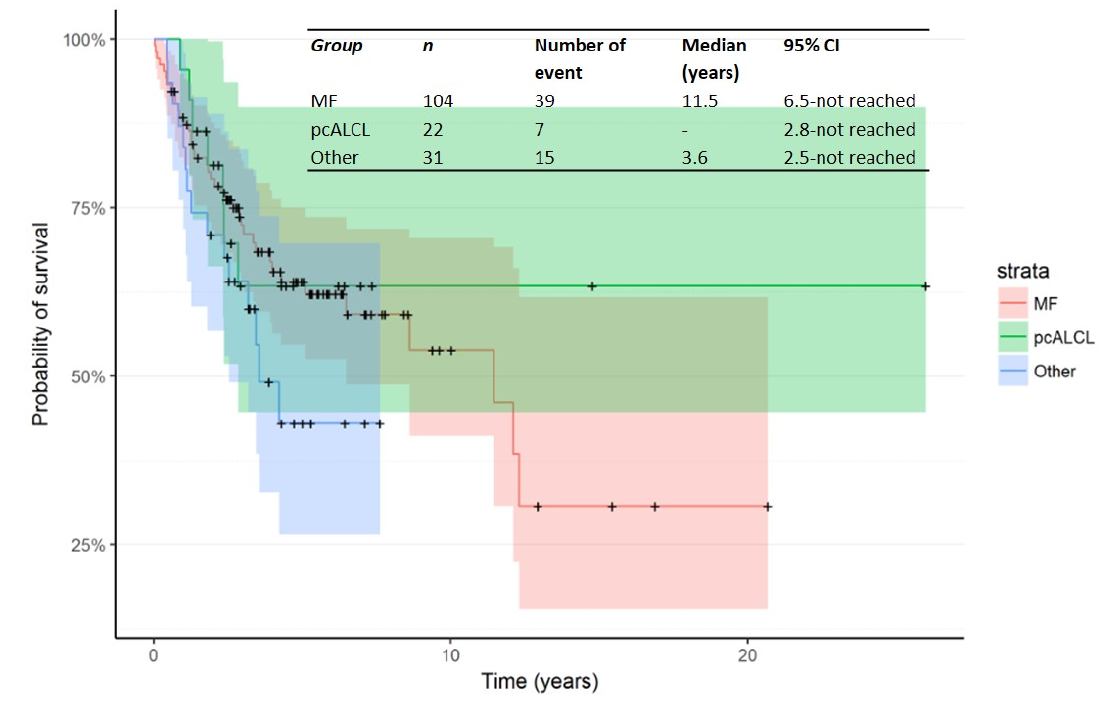
Figure 4. Kaplan–Meier curve for OS from time of R/R1 by primary subtype.